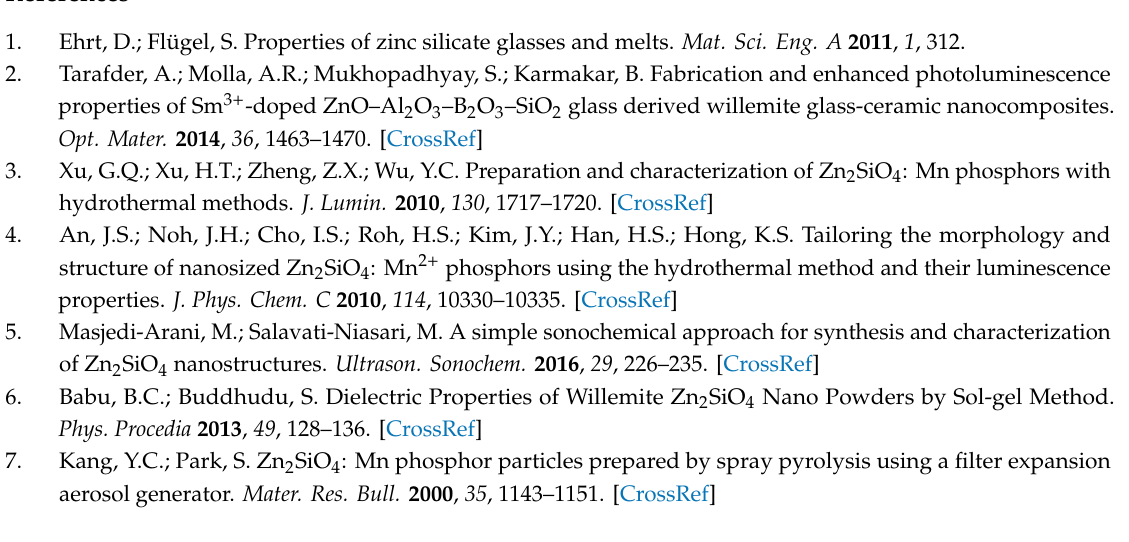
Figure 7. Sample of 55ZnO–5B 2 O 3 –40SLS treated at a various heat-treatment temperatures under ultraviolet–visible (UV) lamp of 254 nm.